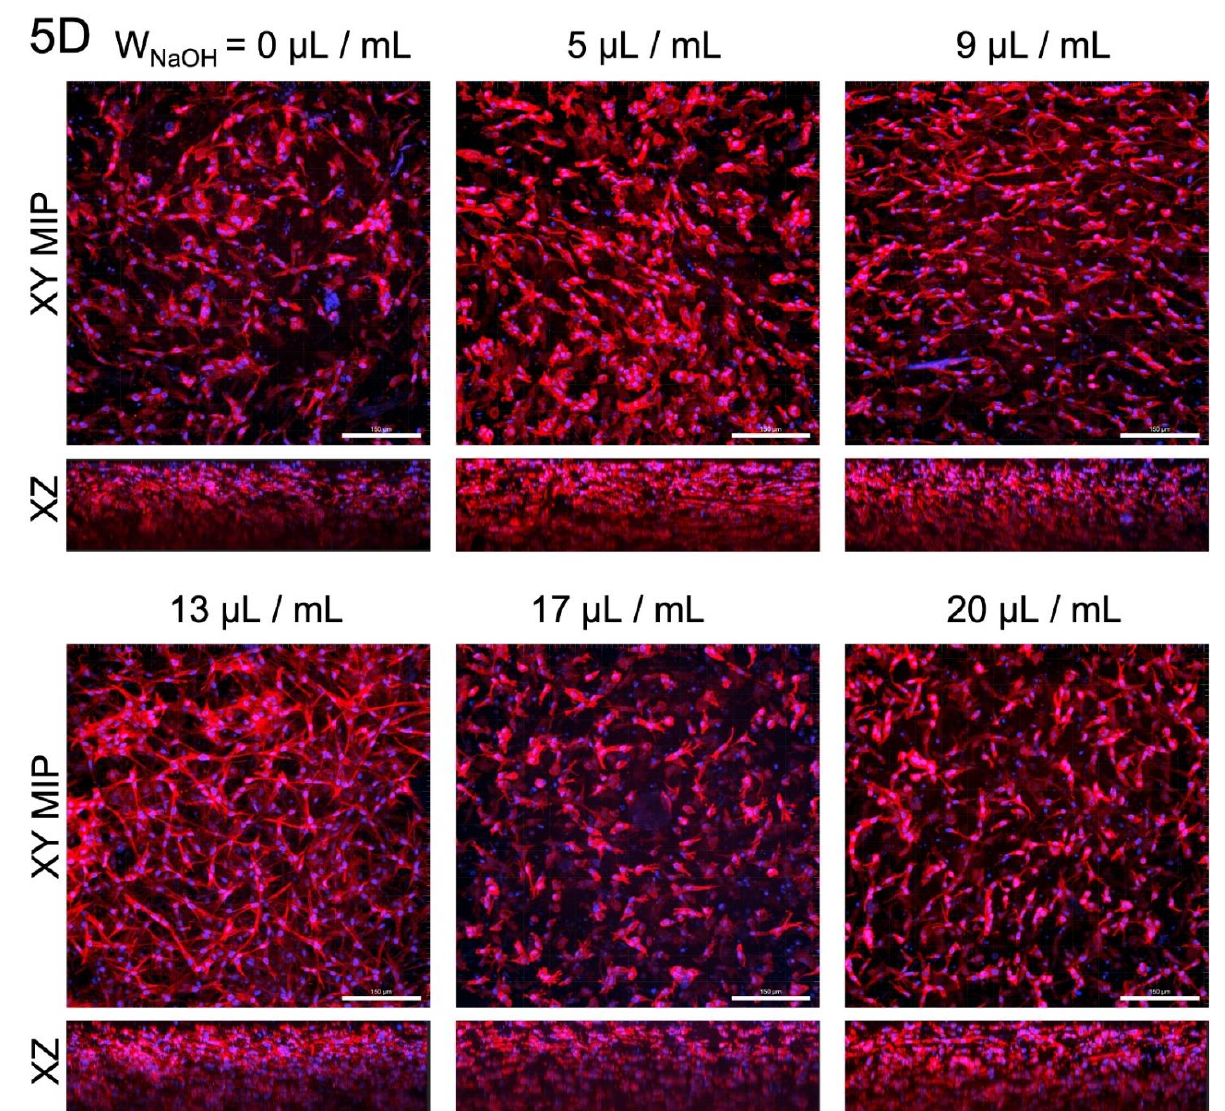
Figure 9. Detailed view of cell cultures of samples with various concentrations of NaOH, including view of the xz plane after 5 days of cultivation. Except for sample 0, cells were relatively homogeneously spread on the cross-sections. The cells were regularly distributed in all samples. F-actin in the cell cytoskeleton was stained with TRITC-conjugated phalloidin. The cell nuclei were counterstained with DAPI. Confocal microscope with spinning disc Nikon CSU-W1, objective CFI Plan Apo VC 20×, scale bar 150 μ m.